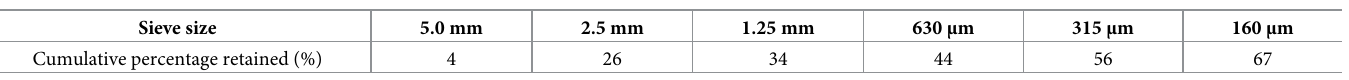
Table 2. Gradation of the river sand.